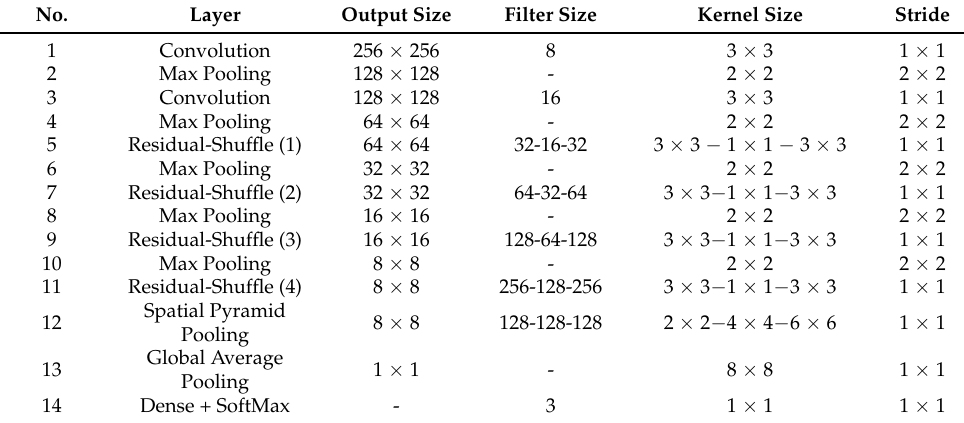
Table 1. Overall architecture of the